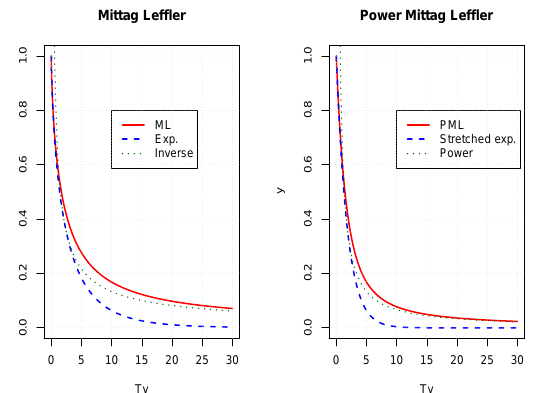
Figure 1. Left and right plots: Comparison of the Mittag–Leffler (ML), E α ( − β t ) , and power Mittag– Leffler (PML), E α ( − β t α ) kernels with exponential and power decreasing functions ( α = 0.7 and β =